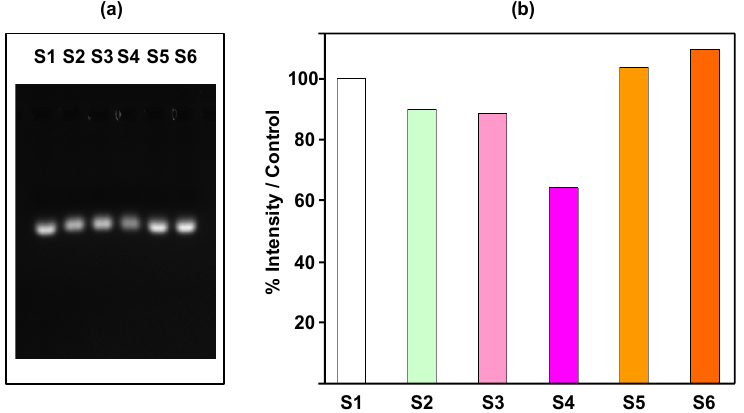
Figure 3. Agarose gel (1%) electrophoresis analysis of Li28 in various experimental conditions. Comparing Li28 diluted in water at pH = 7.5 (S1) or in 0.1 M NaCl (S2), a 10% variation of